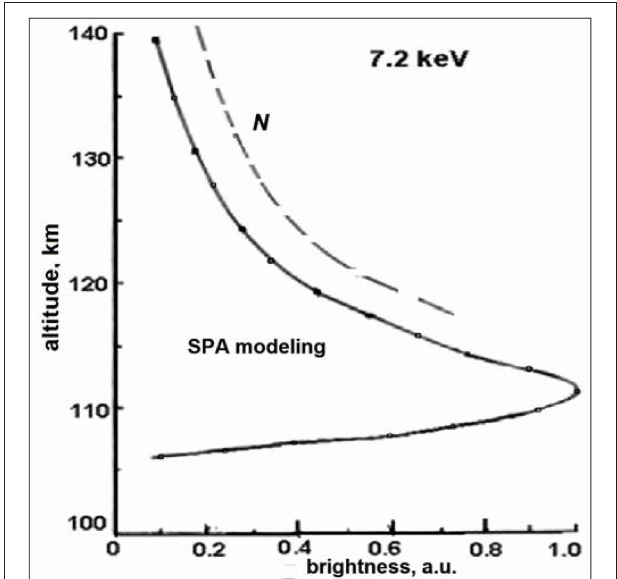
FIGURE 2 | Auroral altitude profile for ε b dashed line shows the relative neutral density from the MSIS model. Adapted from Izhovkina and Mishin (1979). Reprinted by permission from Geomagnetism and